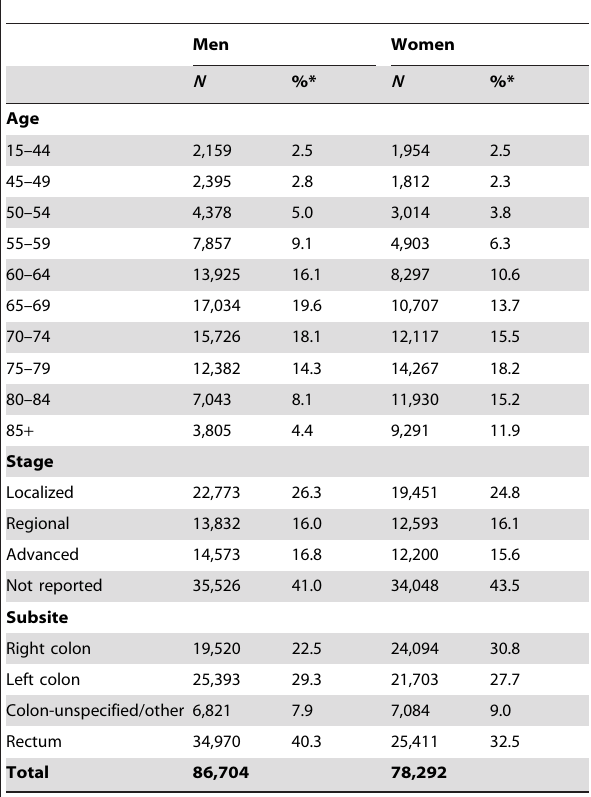
Table 1. Sex differences in distributions of age, stage and subsite in colorectal cancer patients diagnosed between 1997 and 2006.